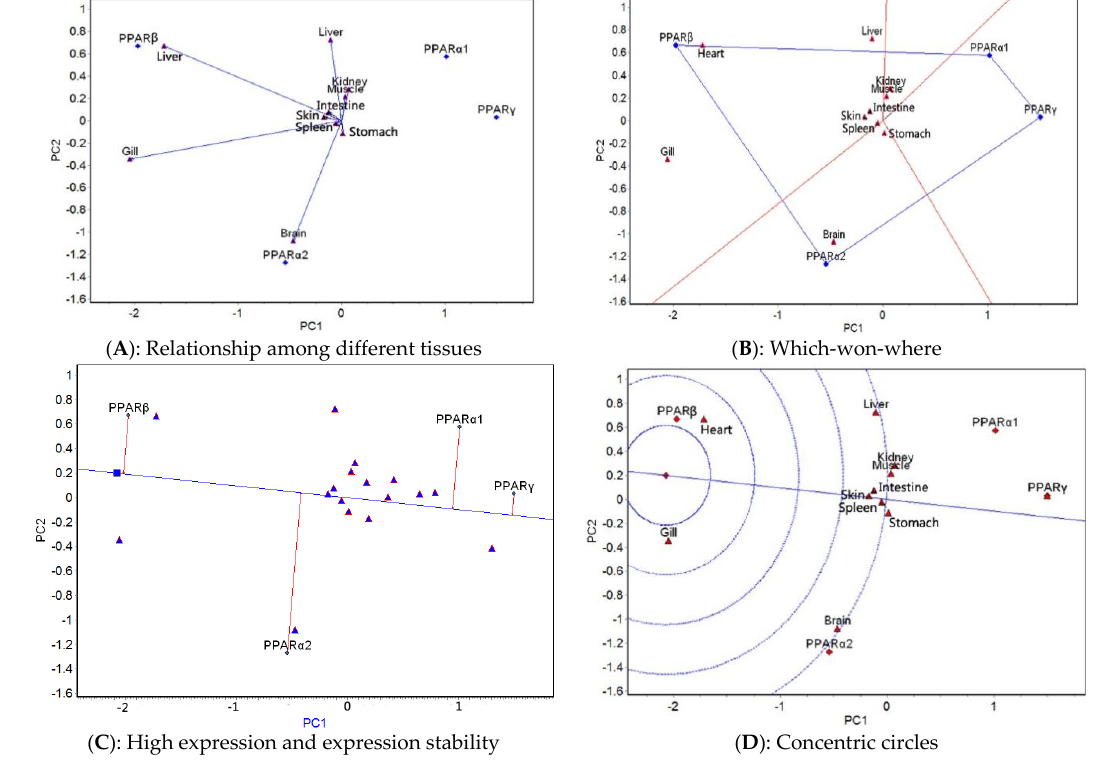
Figure 4. GGE biplots of PPAR genes in different tissues at 20 °C.